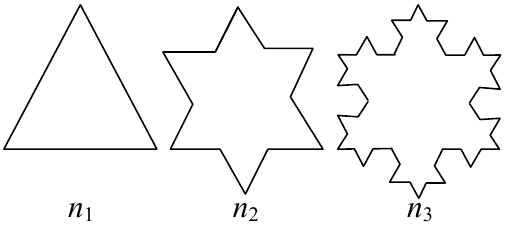
Figure 3. Iterative process of Koch snowflakes structure.